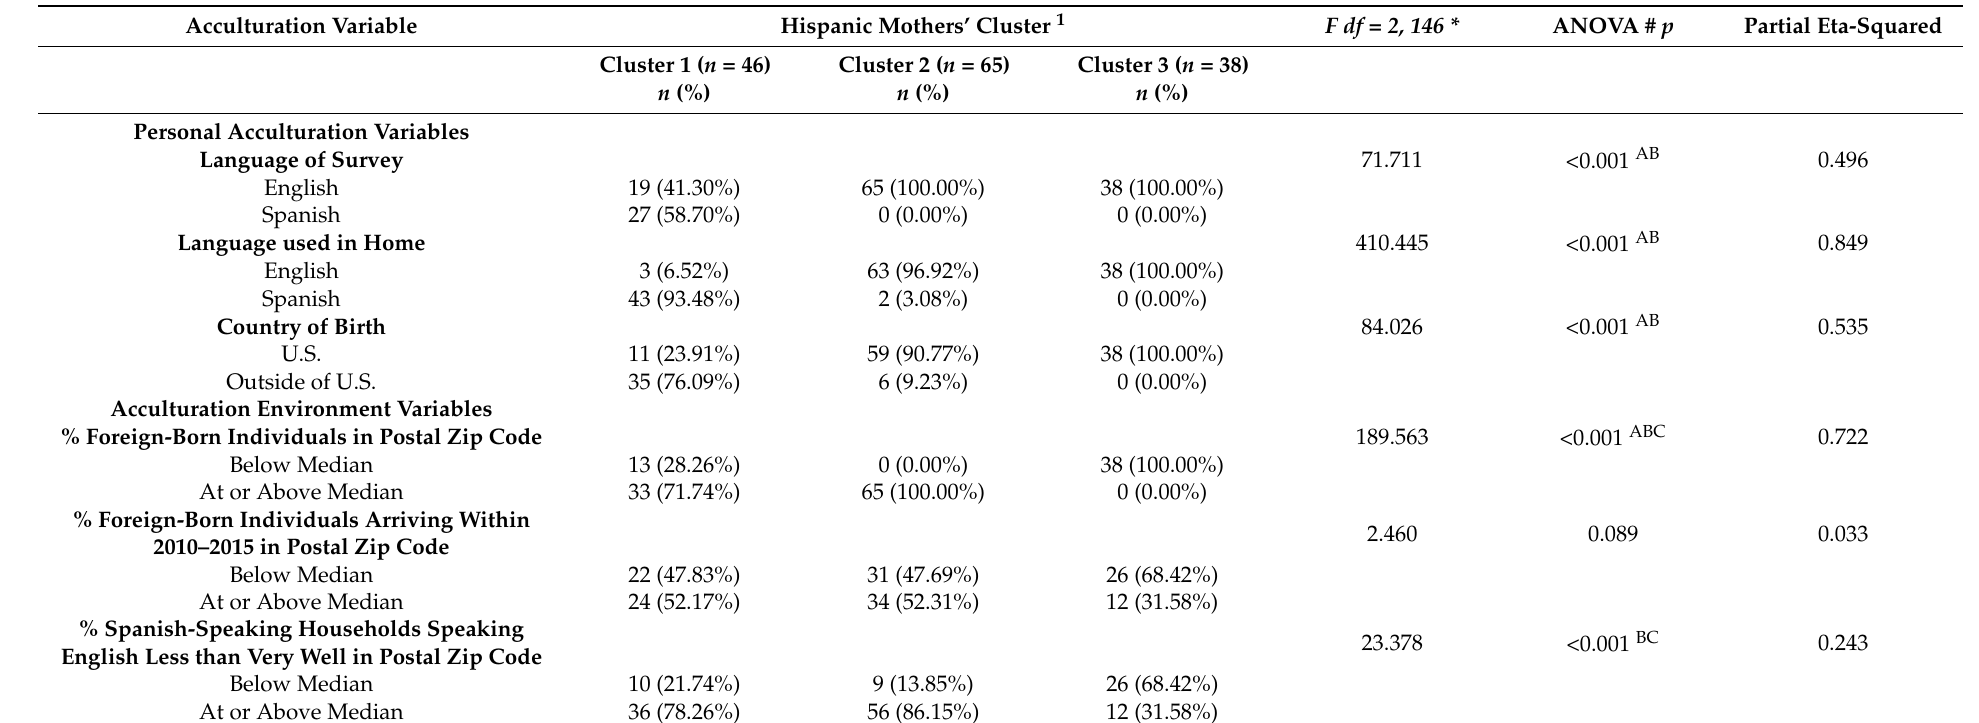
Table 2. Hispanic Mothers Clustered by Acculturation Variables ( n =